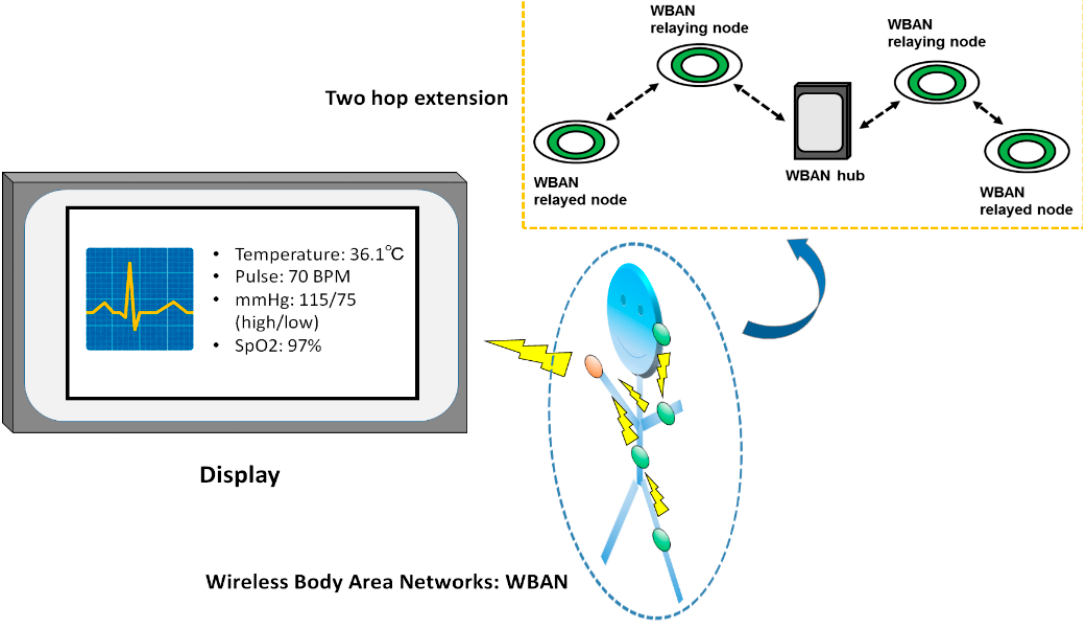
Figure 2. Example smart health care monitoring system.